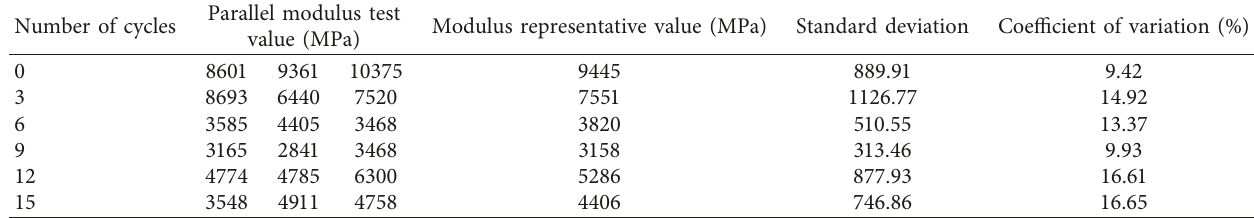
Table 6: Experimental results of dynamic modulus of semirigid base material under the temperature range of 20 ° C ∼ 60 ° C.